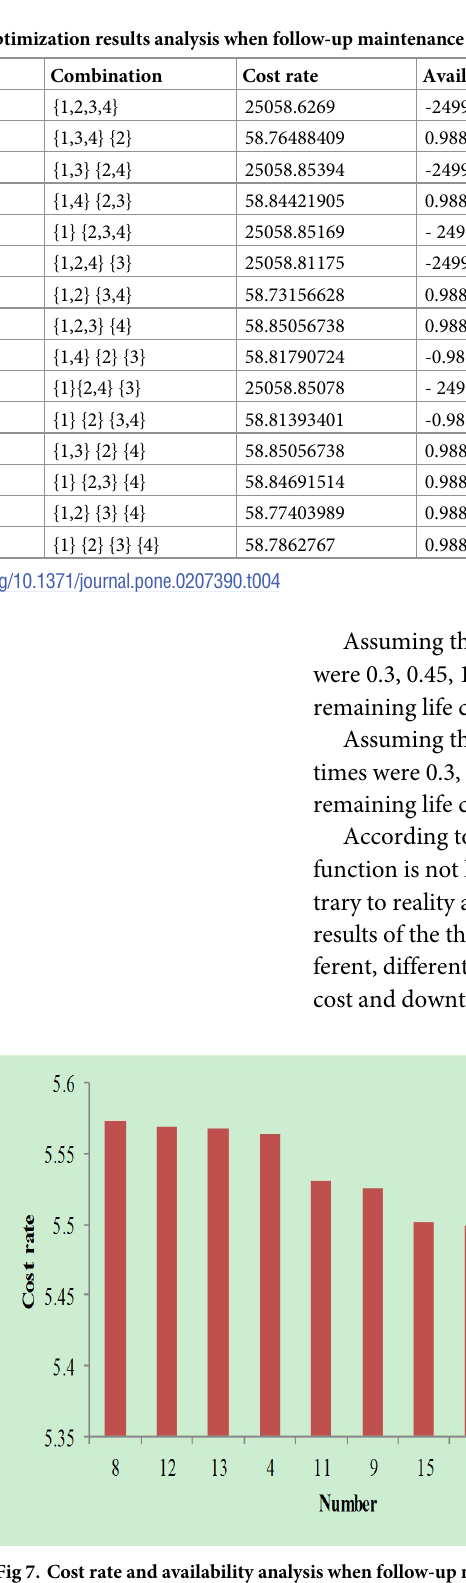
PLOS ONE | https://doi.org/10.1371/journal.pone.0207390 November26,